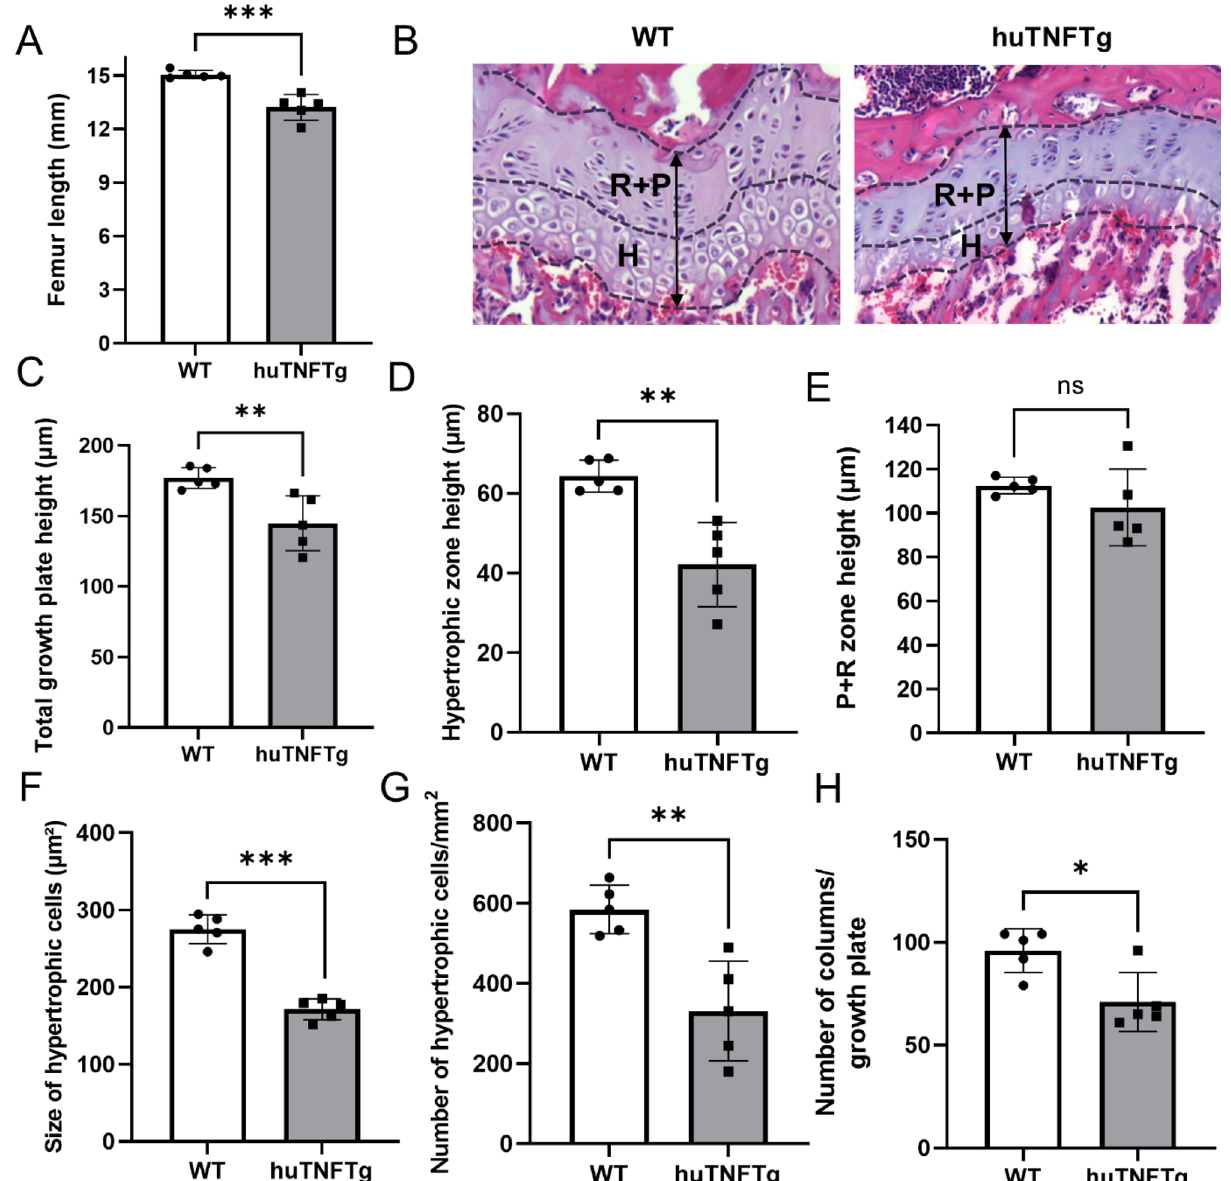
Figure 1. Overexpression of human TNF impaired bone growth and chondrogenesis in mice. Analysis performed in female wild type (WT) and female huTNFTg mice (n = 5). (A) Femur lenth in 8-week-old mice measeured at sacrifice by caliper. (B) Representative images indicating different zones and growth plate height in the femur in each group. (C) Total growth plate height. (D-E) Height measurements of hypertrophic zone and resting + proliferative (R + P) zone. ( F ) Measurements of size of hypertrophic cells in femur growth plates in each group. (G) Analysis of number of hypertrophic cells per growth plate section in each group. (H) Analysis of number of columns per growth plate section in each group. Error bar indicate mean ± SD. Students t-test was used to analyze differences between groups. * p < 0.001, ** p < 0.01, *** p <